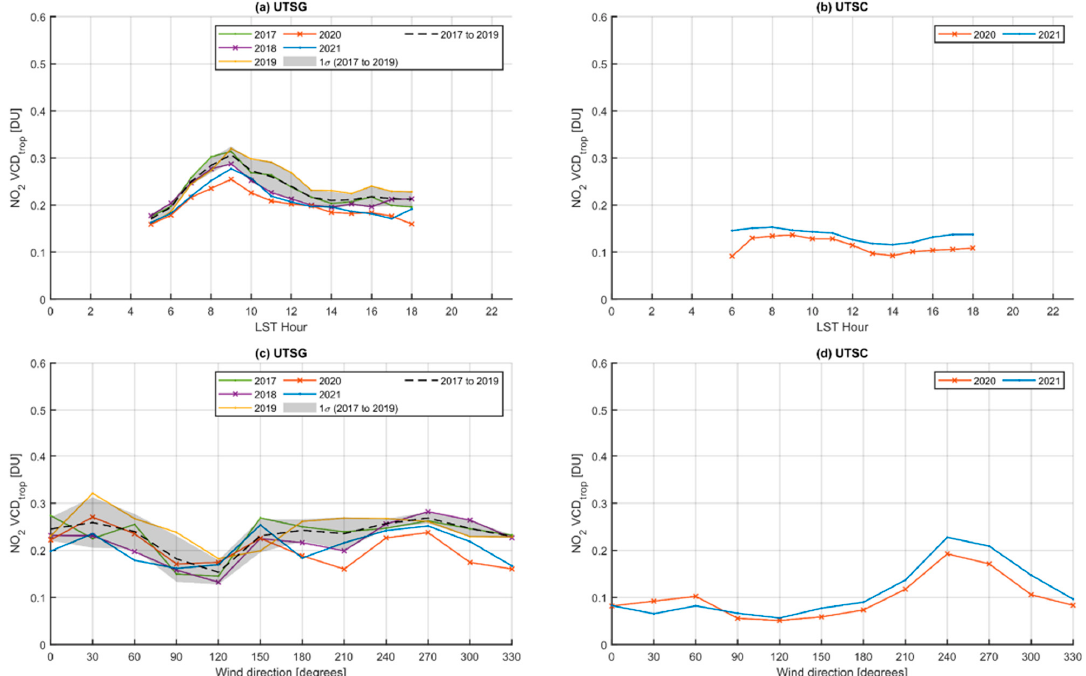
Figure 6. Pandora measured NO 2 tropospheric column at UTSG ( a , c ) and UTSC ( b , d ) sites binned by local standard time (LST) in hours and wind directions (observations from 15 March to 15 September of each year). The black dashed line is the mean of observations from 2017 to 2019, with the shading area representing the standard deviation of the 5-year mean.